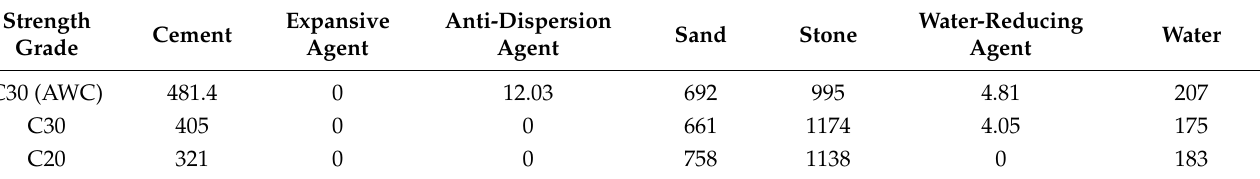
Table 4. The mix ratio of the concrete (kg/m 3 ).